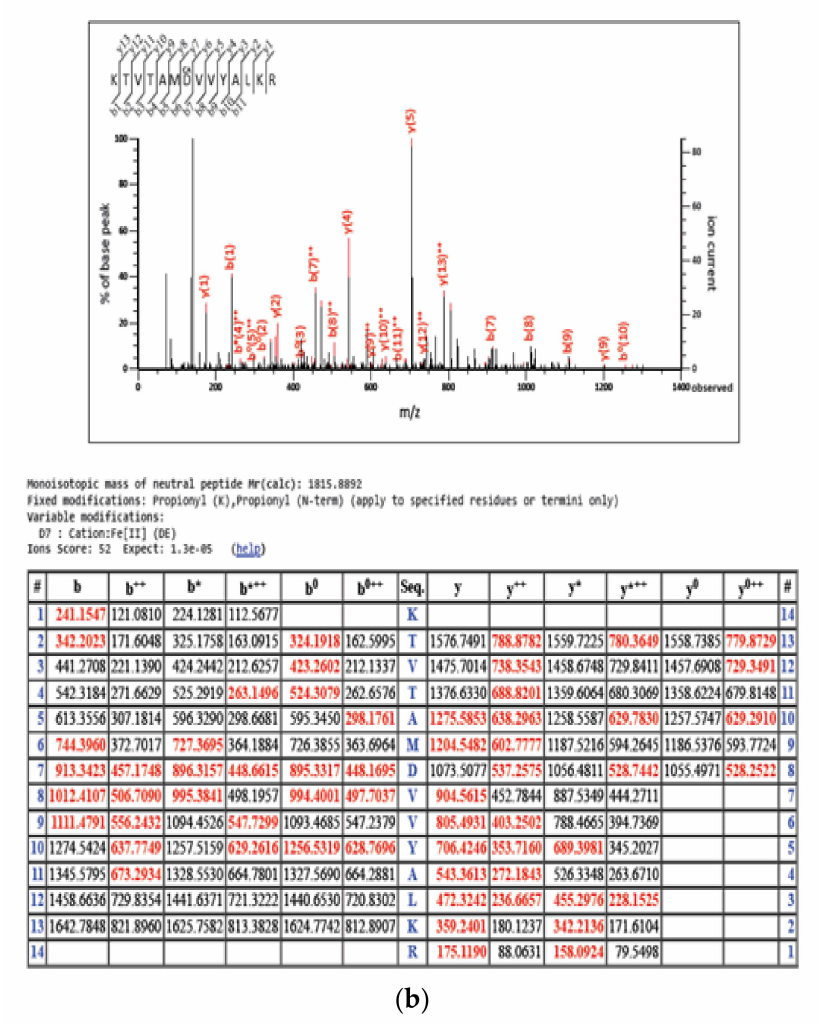
Figure 3. ( a ) Overview of progressive significant ( p < 0.05) changes in histone post-transcriptional modifications (PTMs) in MM1 cells after RSL3 treatment compared to untreated controls. Each symbol depicts a different PTM. Red symbols represent downregulated modifications whereas green symbols represent upregulation. The position of each PTM is indicated by the amino acid (AA) single-letter code and its AA position within the corresponding histone protein sequence. ( b ) Annotated H4 MS/MS spectrum demonstrating Fe 2+ binding to H4 glutamate (E) and aspartate (D) residues under ferroptotic conditions. Coverage of detected b and y ions are presented in the lower table, with # indicating fragment index and “Seq.” referring to the amino acid residue. B and y ions displayed in the figure are singly charged, unless otherwise indicated by their index (++ indicates a doubly charged fragment ions). Ions marked with an asterisk (*) represent ions with ammonium loss, ions marked with a circle ( ◦ ) represent ions with water